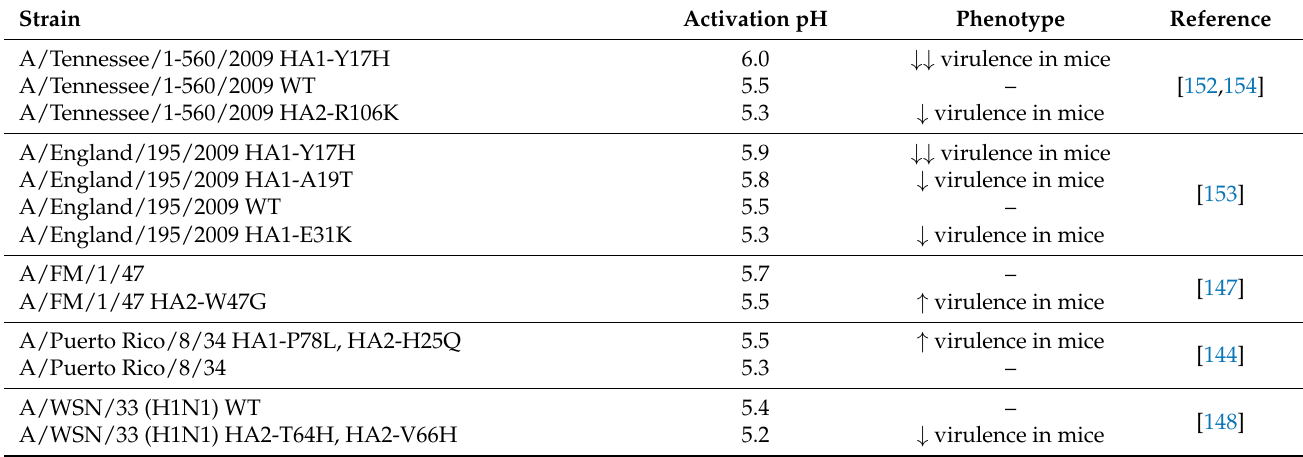
Table 2. Phenotypes of seasonal and pandemic H1N1 variants in